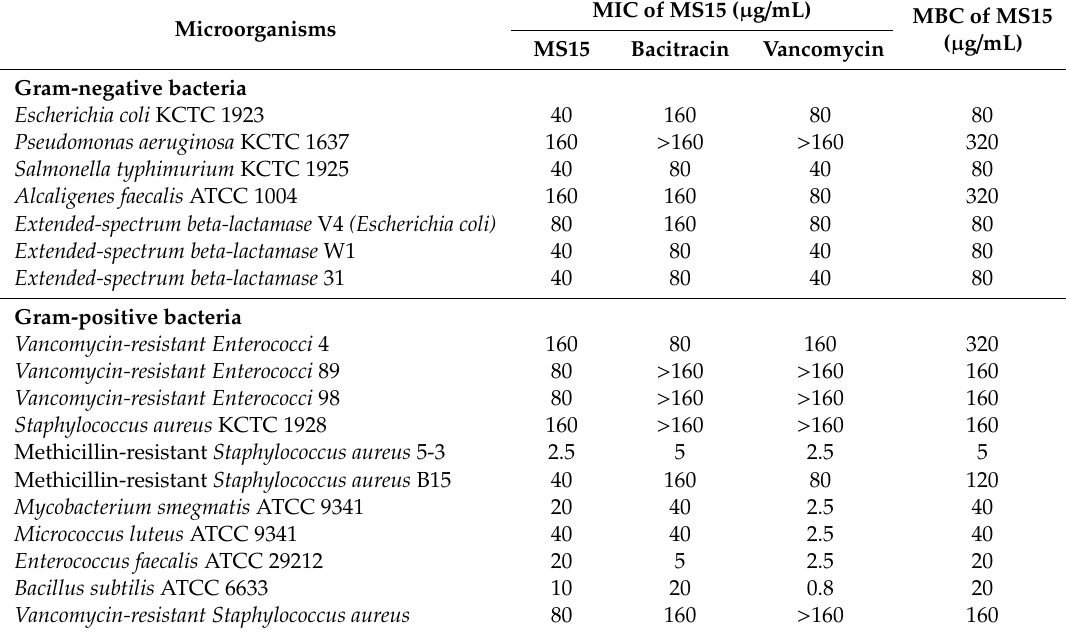
MIC of MS15 ( µ g / mL) MBC of MS15